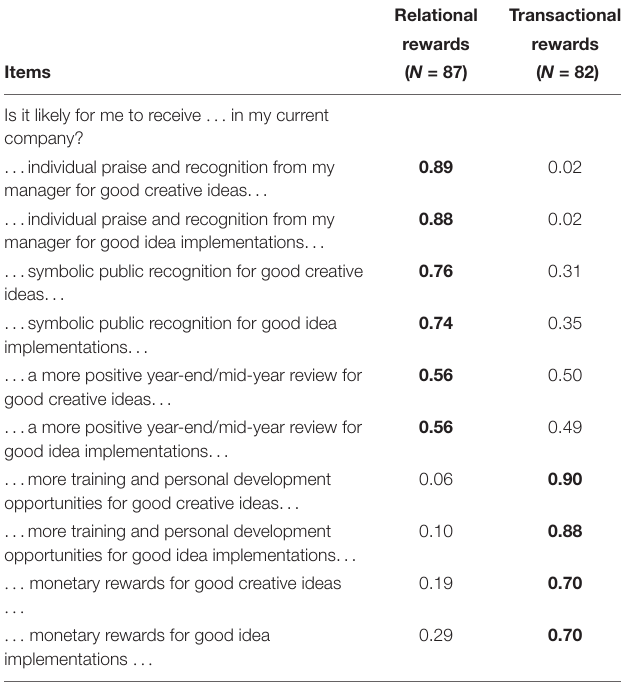
TABLE 4 | Pattern and structure matrix of PCA with varimax rotation for a two-factor solution of reward-items.